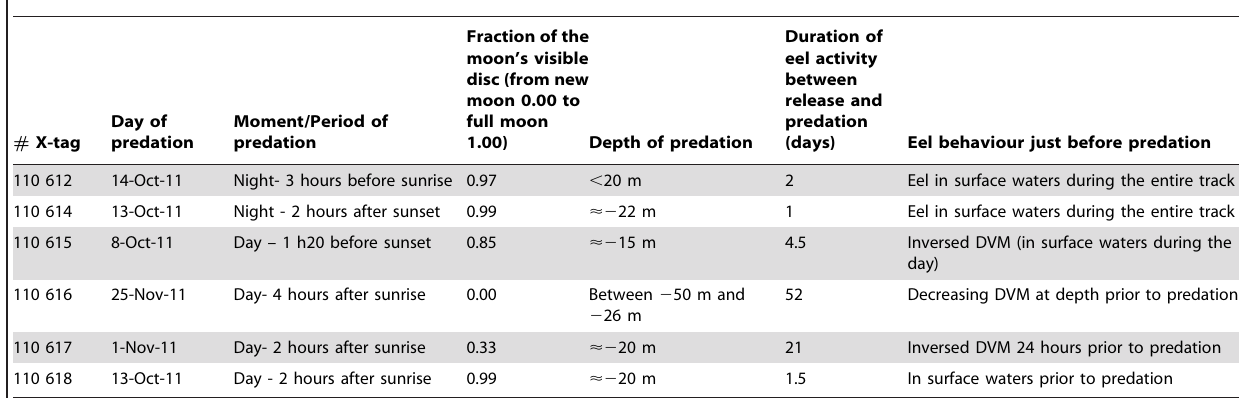
Table 3. Environmental variables and eel behavior observed just prior to and at the moment of